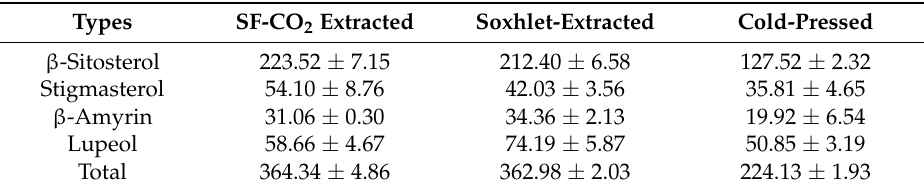
Table 5. Phytosterols in EDS oil extracted by different methods (mg/100 g).